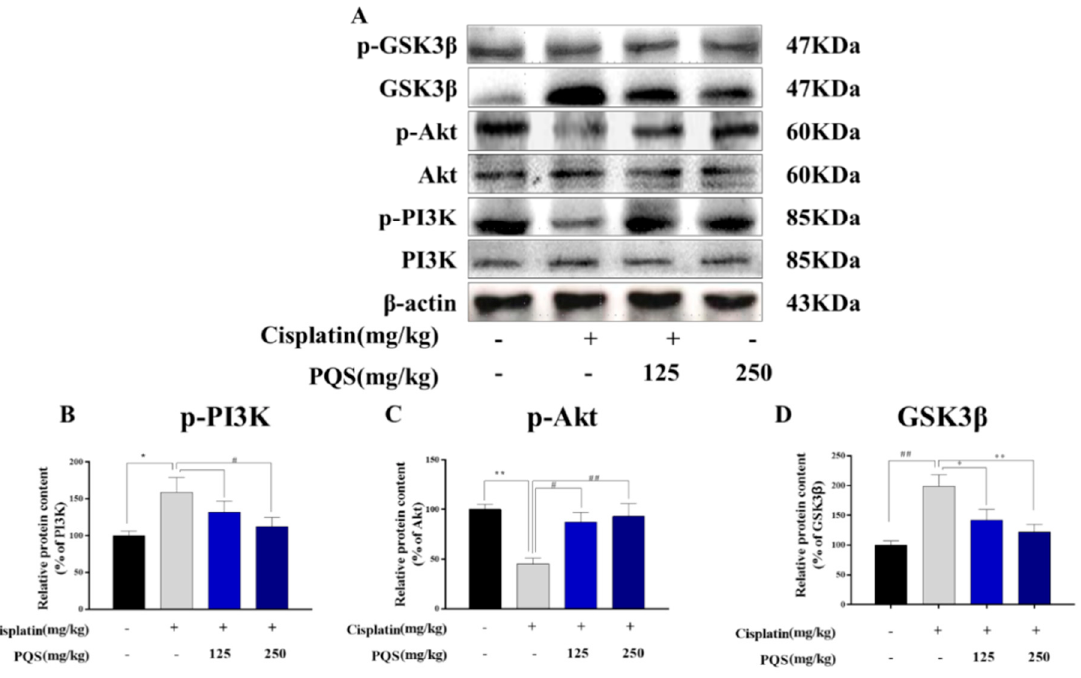
Figure 8. Mice pretreated with PQS or saline for 7days, given with or without cisplatin at day 7th, 9th, 11th and 13th. ( A ) Representative western blots depicting total and phosphorylated PI3K, Akt, GSK-3 β . Quantitative analyses of the p-PI3K / PI3K, p-Akt / Akt, and p-GSK-3 β / GSK-3 β expression ratios are shown ( B – D ). All data were expressed as mean ± S.D. * p < 0.05, ** p < 0.01 comparing with normal group. # p < 0.05, ## p < 0.01 comparing with cisplatin group.